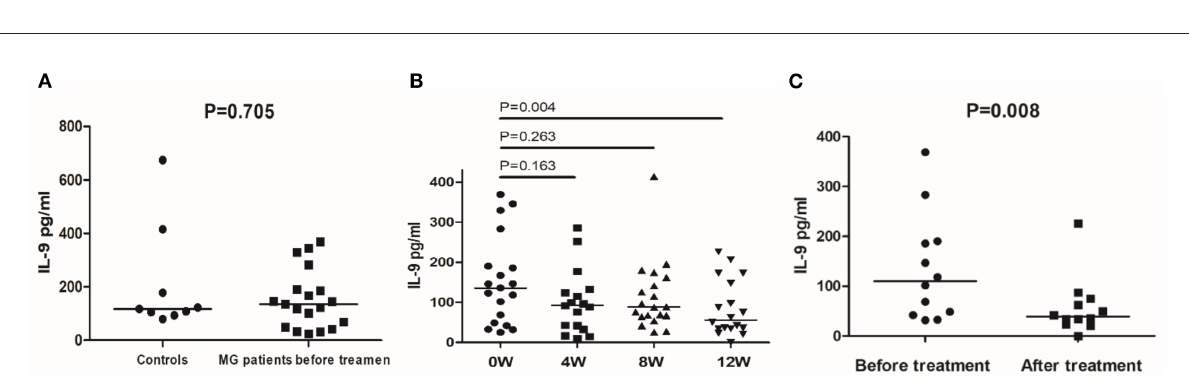
FIGURE4 IL-9 secretion detected by ELISA in controls and MG patients. (A) IL-9 secretion in PBMCs of healthy controls and MG patients before treatment. (B) IL-9 secretion in PBMCs of MG patients before treatment and after 4, 8, and 12 weeks of treatment. (C) IL-9 secretion in PBMCs of responsive MG patients before treatment and at 12 weeks. The horizontal bars indicate the median. The amount of IL-9 secretion was a continuous variable with a non-normal distribution; We compare MG patients and controls using Welch’s corrected unpaired rank sum test. We compared before and after treatment using a paired rank sum